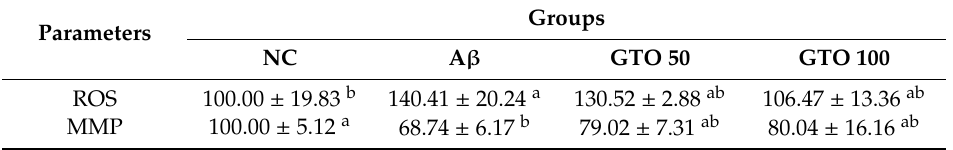
Table 3. Protective effect of green tea seed oil (GOT) on A β -induced mitochondrial dysfunction. Parameters